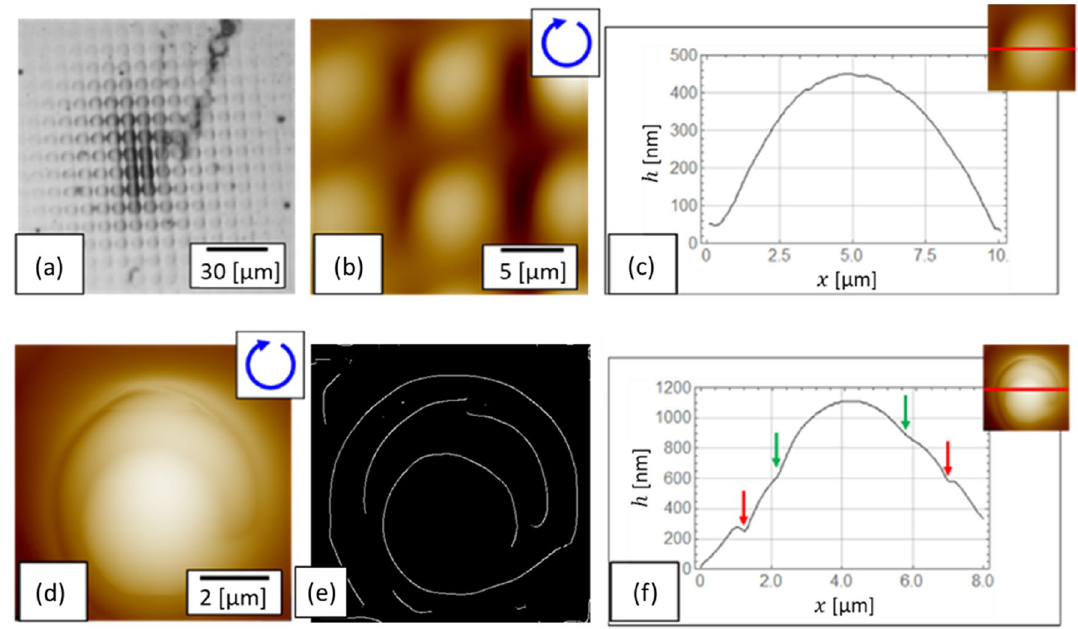
Figure 7. Surface morphology of the structure fabricated by ( a – c ) 4-beam and ( d – f ) 6-beam interference patterns. A right-handed circular polarized beam was used in both cases. ( a ) Optical image, ( b , d ) AFM images, ( c , f ) cross-sectional graphs of ( b ) and ( d ), ( e ) edge detection processed image of ( d ). ( d , f ) are reproduced from reference 16. Copyright 2018, Nature Publishing